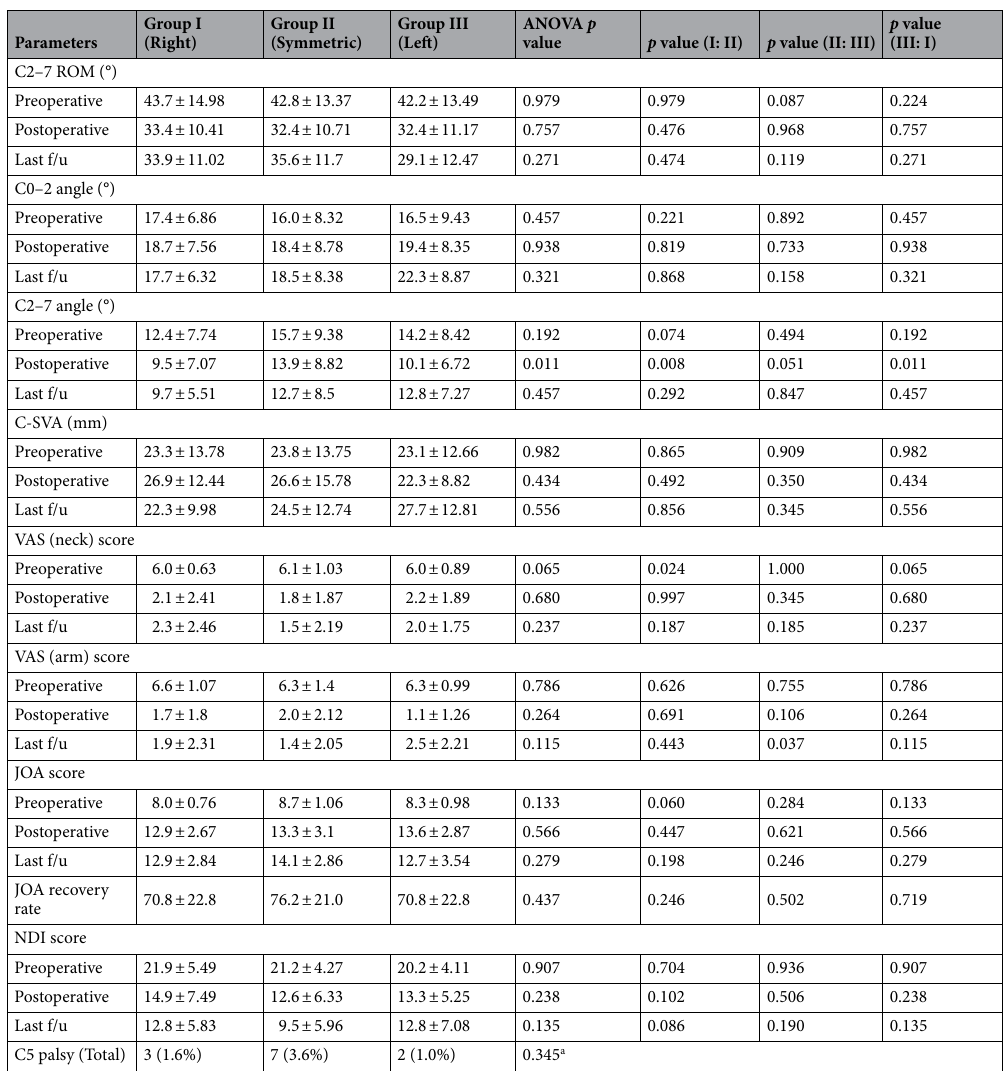
Table 2. Comparison of outcomes according to dominant compressive side. C-SVA indicated cervical sagittal vertical axis; VAS visual analog scale; JOA Japanese orthopaedic association; NDI neck disability index. *Statistically significant ( p value < 0.05). a Chi-square test.